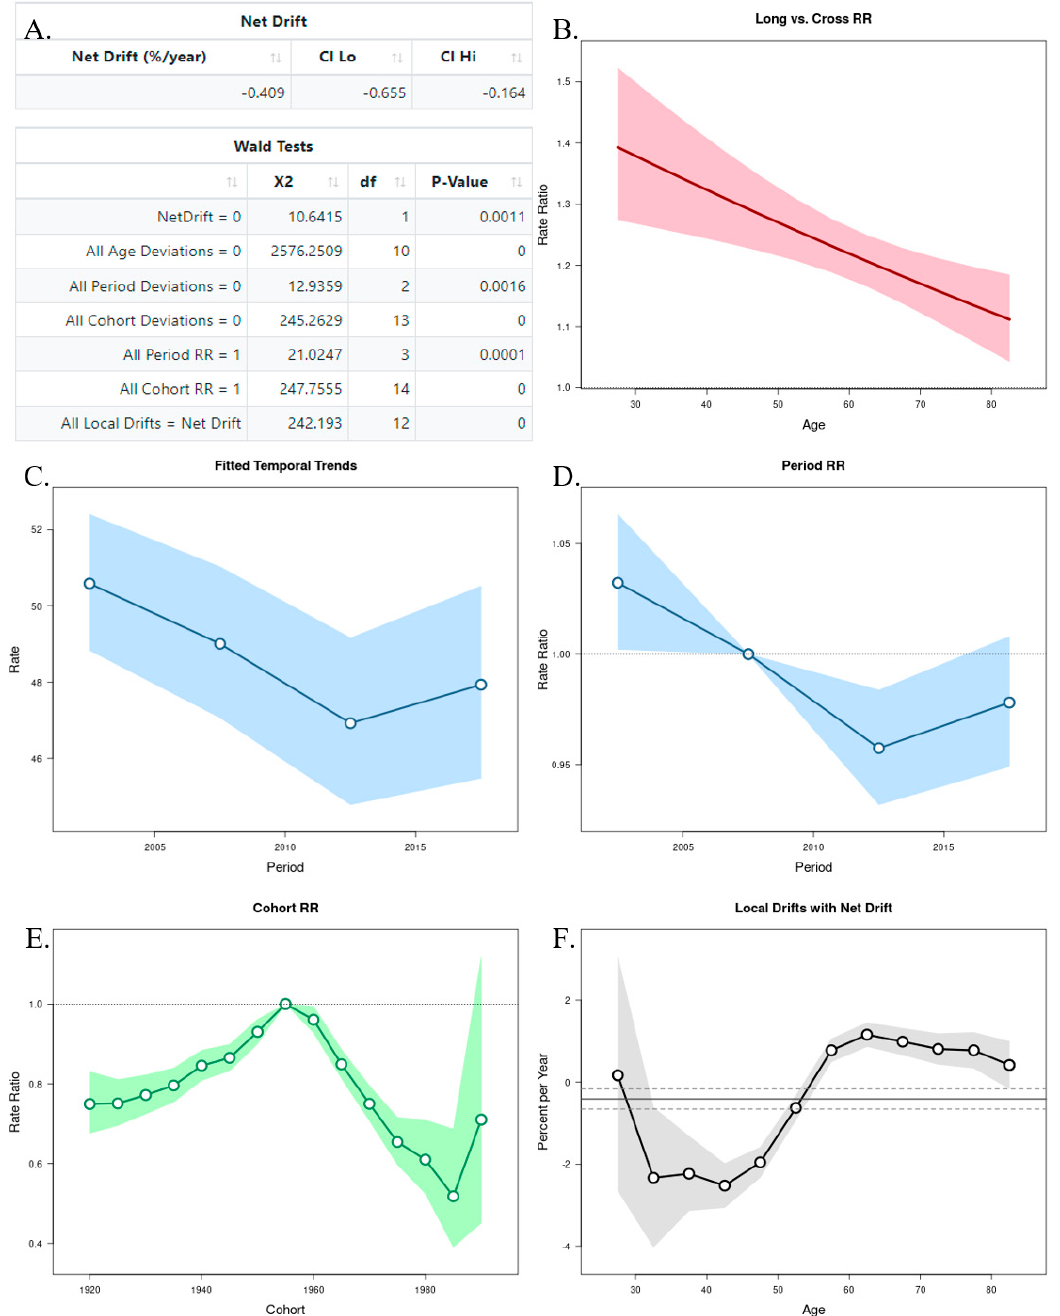
Figure 7. Age–Period–Cohort (APC) analysis with Wald test ( A ), representation of the age ( B ), period ( C , D ), and cohort effects ( E , F ) in males.